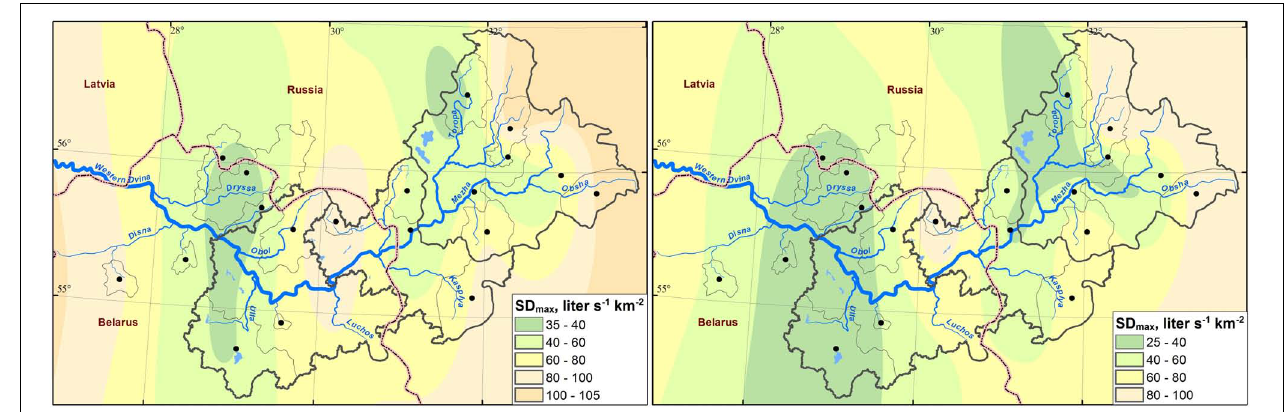
FIGURE 9 | Decadal variability of maximum specific discharges (liter s − 1 km − 2 ) on the Western Dvina River and its